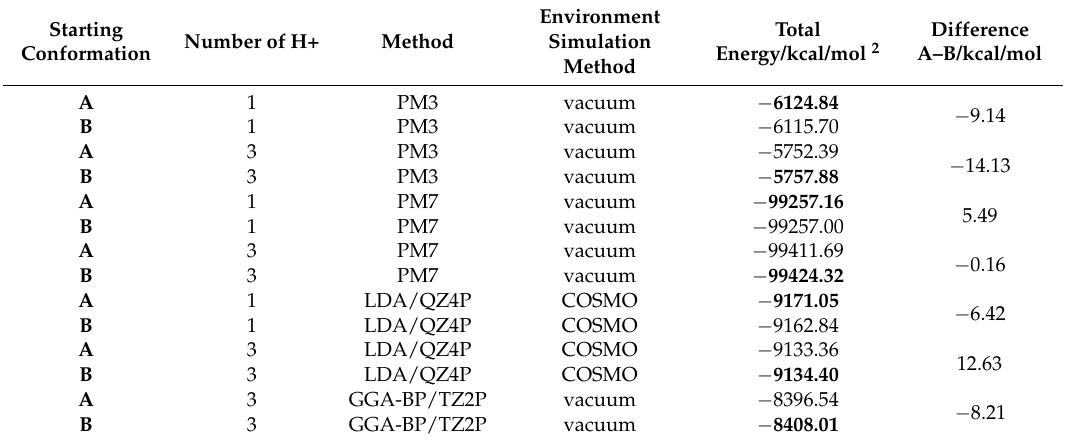
Table 3. Calculated energies for each protonation state and conformation, closed ( A ) and open ( B ) 1 . Starting Number of H+ Conformation